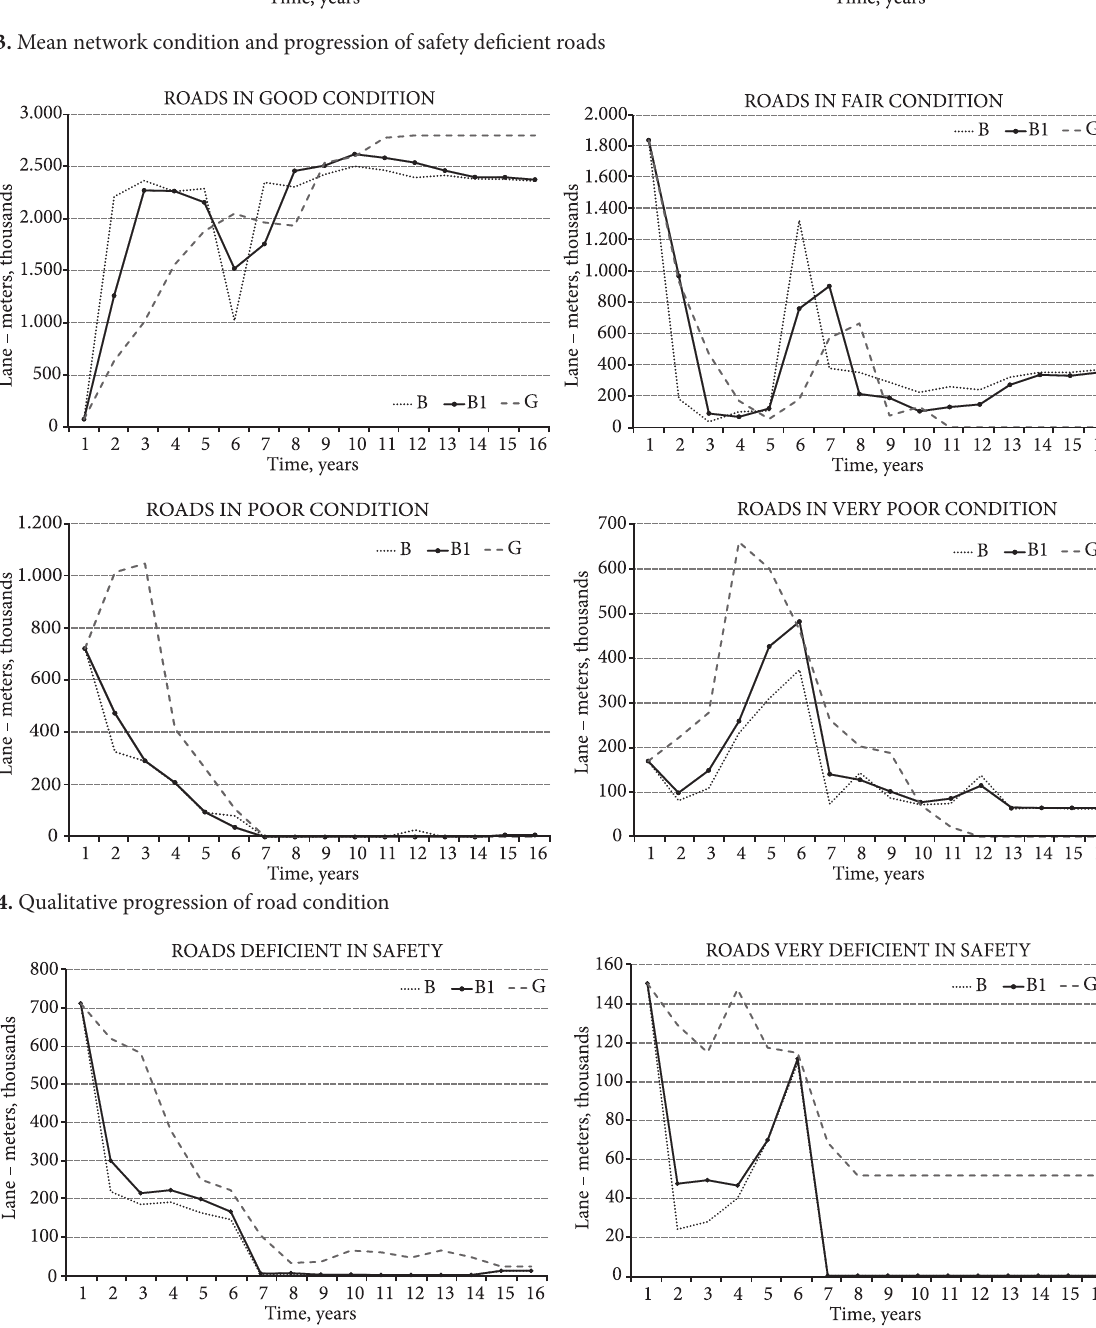
fig. 5. Qualitative progression of road